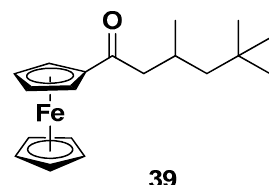
Figure 20. Structure of (3,5,5-trimethylhexanoyl)ferrocene .